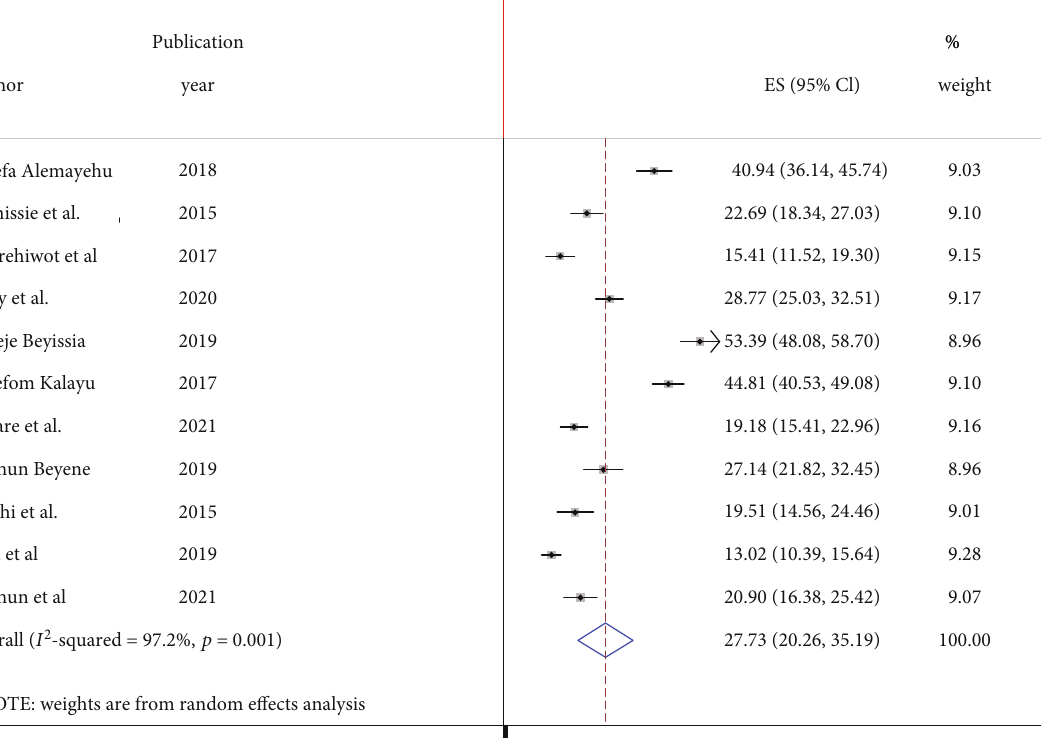
Figure 2: Forest plot in pooled prevalence of dual contraceptive use in